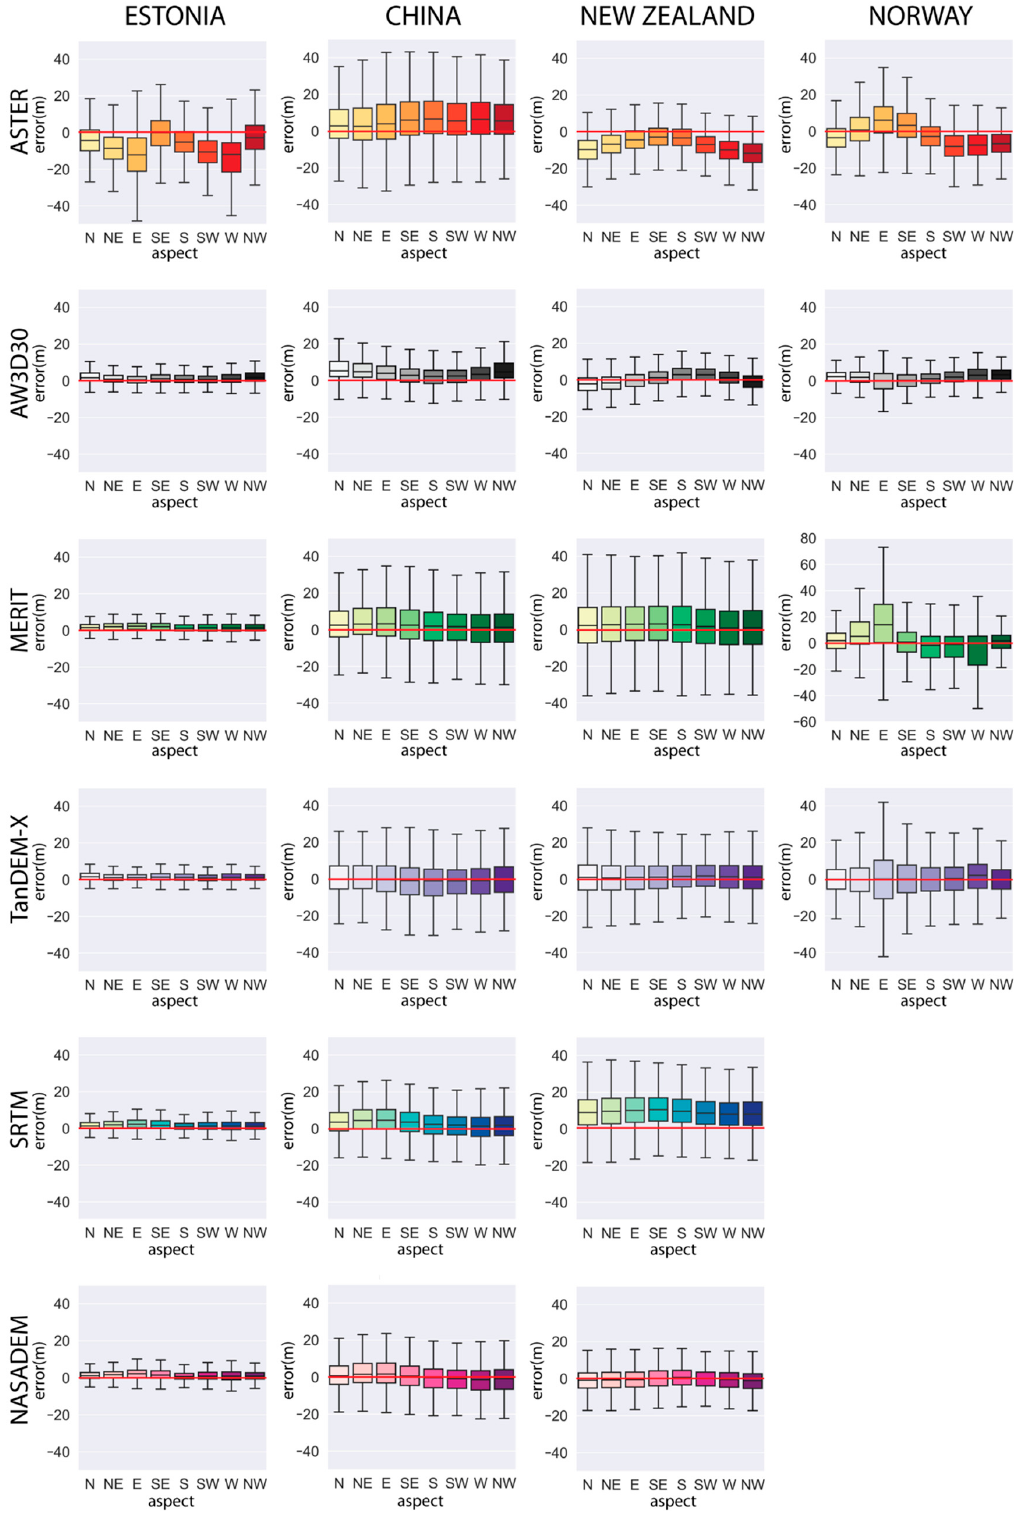
Figure 5. Box plots of errors by slope aspect class for all global digital elevation models for the four study areas. SRTM and NASADEM data were not available for the Norwegian study area because of its high latitude. The central horizontal line in the box marks the median; the boxes show the interquartile range (25th to 75th percentile), and the whiskers show 1.5 times the interquartile range.